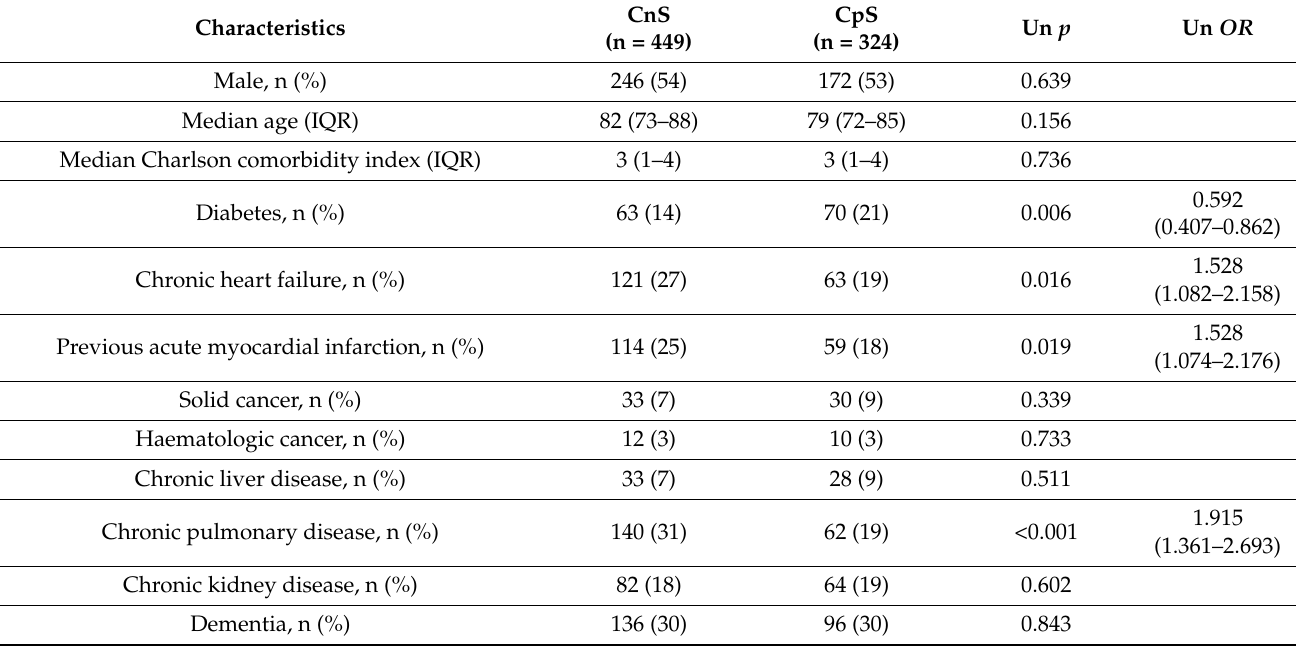
Table 1. Characteristics at